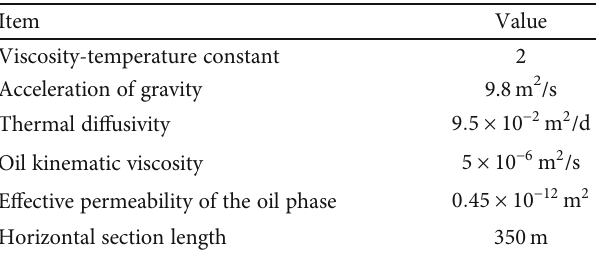
Figure 10: Schematic of the lateral expansion speed of the steam chamber under di ff erent convective liquid heat capacities. Table 3: Basic parameter table for yield calculation.